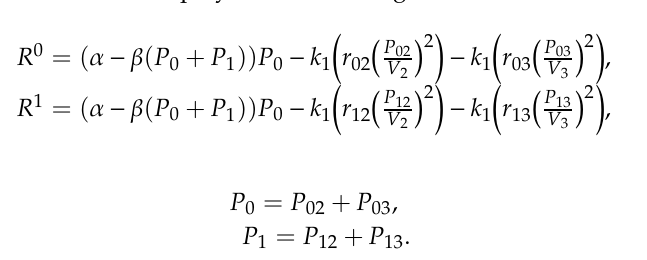
Figure 5. 𝑃 02 with different values of 𝛾 . Figure 5. P 02 with di